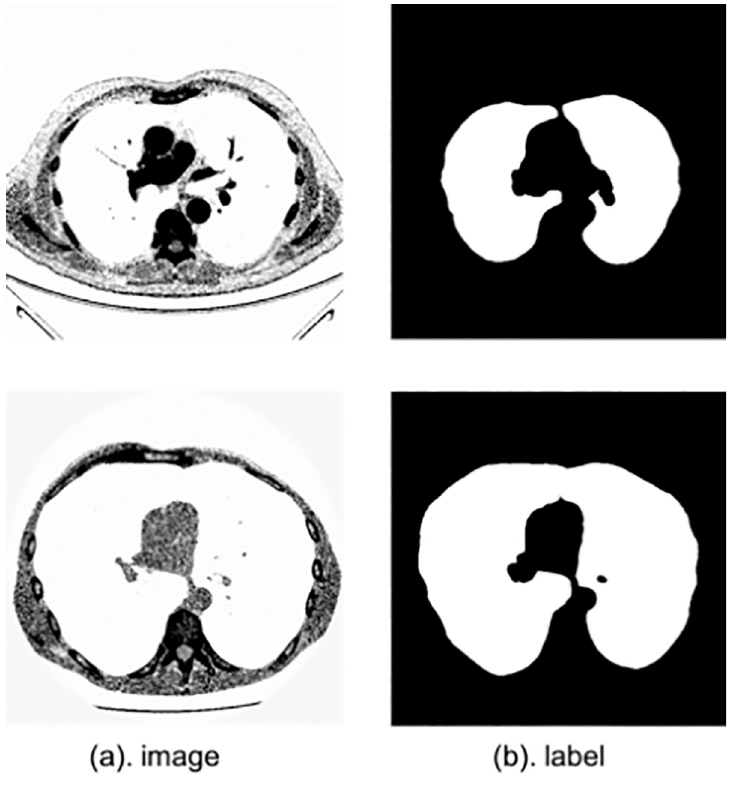
Fig 6. Sample lung CT images with dimensions of H × W in